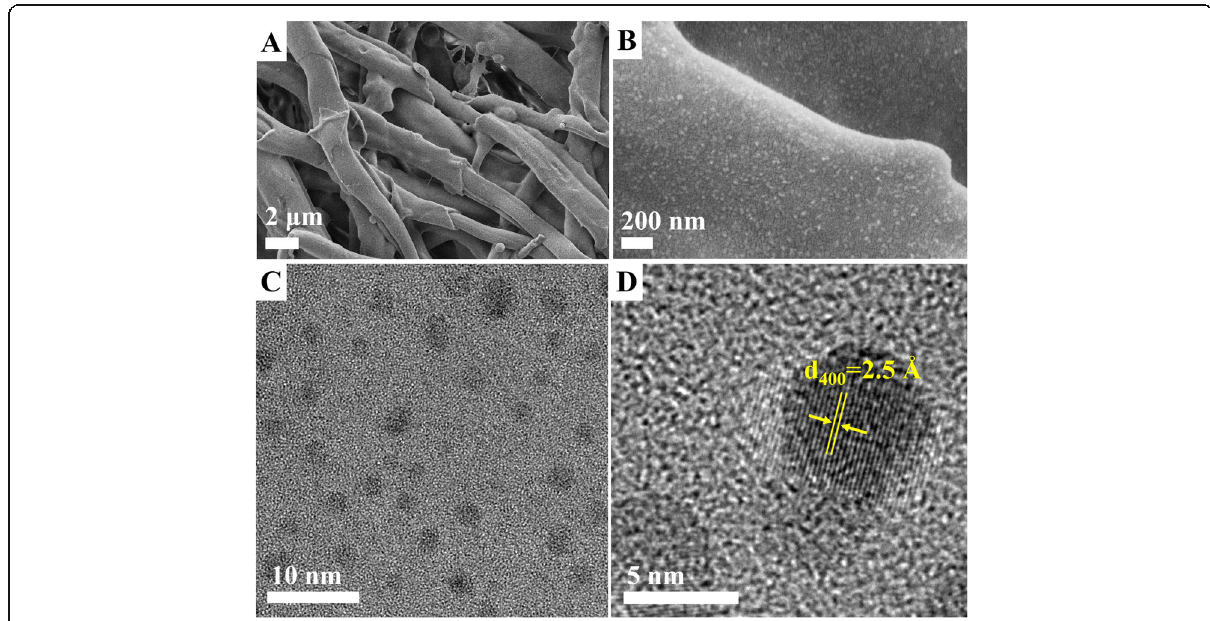
Fig. 2 The SEM images of MnO 2 NPs/ESM with different scale bars (2 μ m ( a ) and 200 nm ( b )). The TEM ( c ) and HRTEM ( d ) images of MnO 2 NPs, the scale bars were 10 nm and 5 nm,